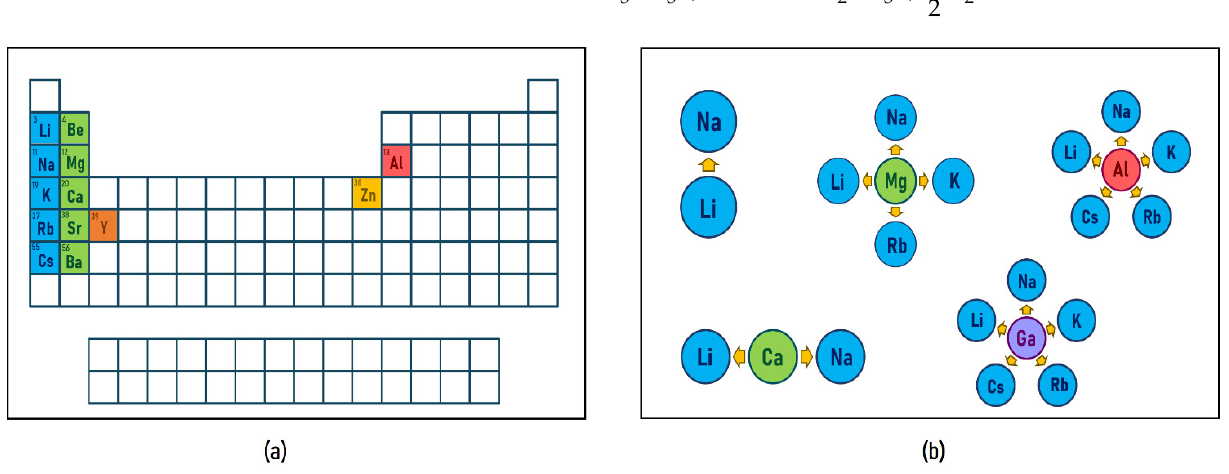
Figure 15. ( a ) Reported monometallic amidoboranes, either experimentally or theoretically; ( b ) combinations of metals for bimetallic amidoboranes that have been reported, either experimentally or theoretically.